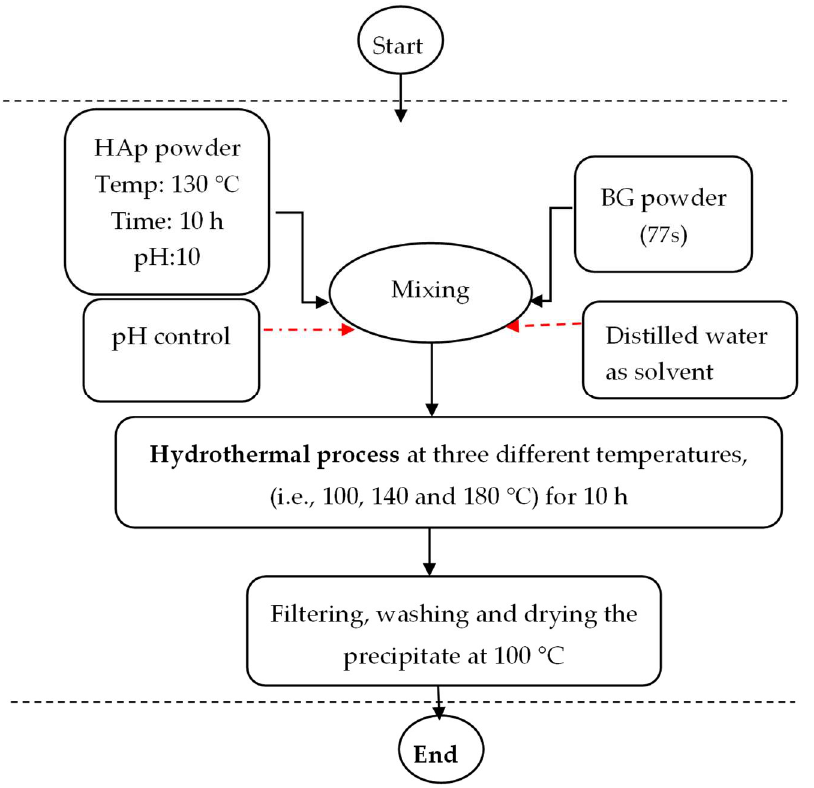
Figure 1. Flowchart for the synthesis of HAp/BG nanocomposite by the hydrothermal method.